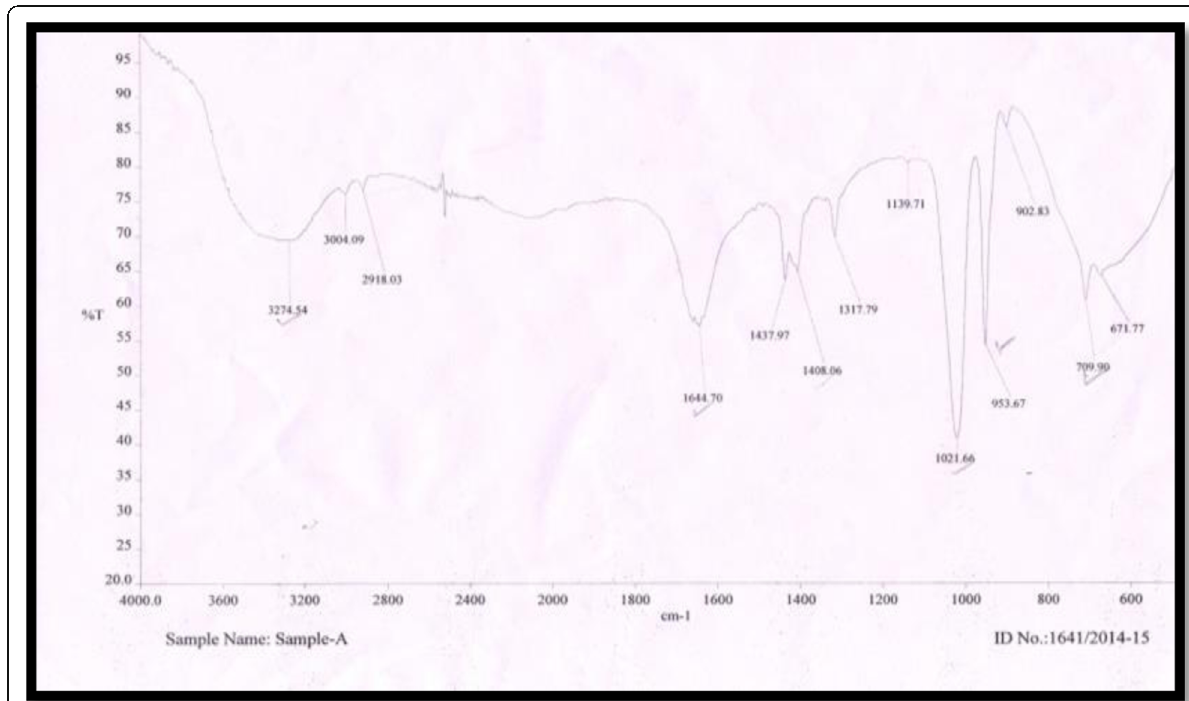
Fig. 3 FTIR analysis of methanolic extract of Praecitrullus fistulosus